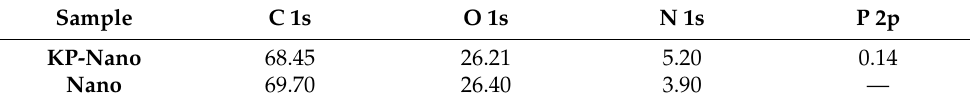
Table 2. XPS surface chemical composition of KP-Nano and Nano a .